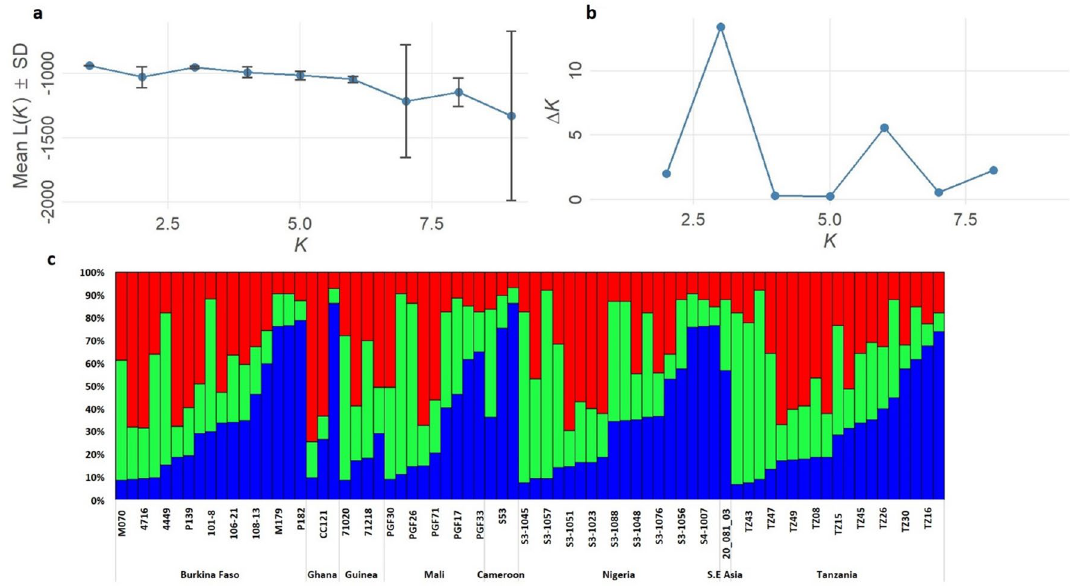
Figure 4. Population differentiation and ancestry using STRU CTU RE showing optimal K value ( K = 3) by the method of Evanno ( a ) mean likelihood of K and ( b ) ΔK . ( c ) Bar plot of individual Bayesian assignment probabilities of microsatellites for P. malariae from different countries with admixture